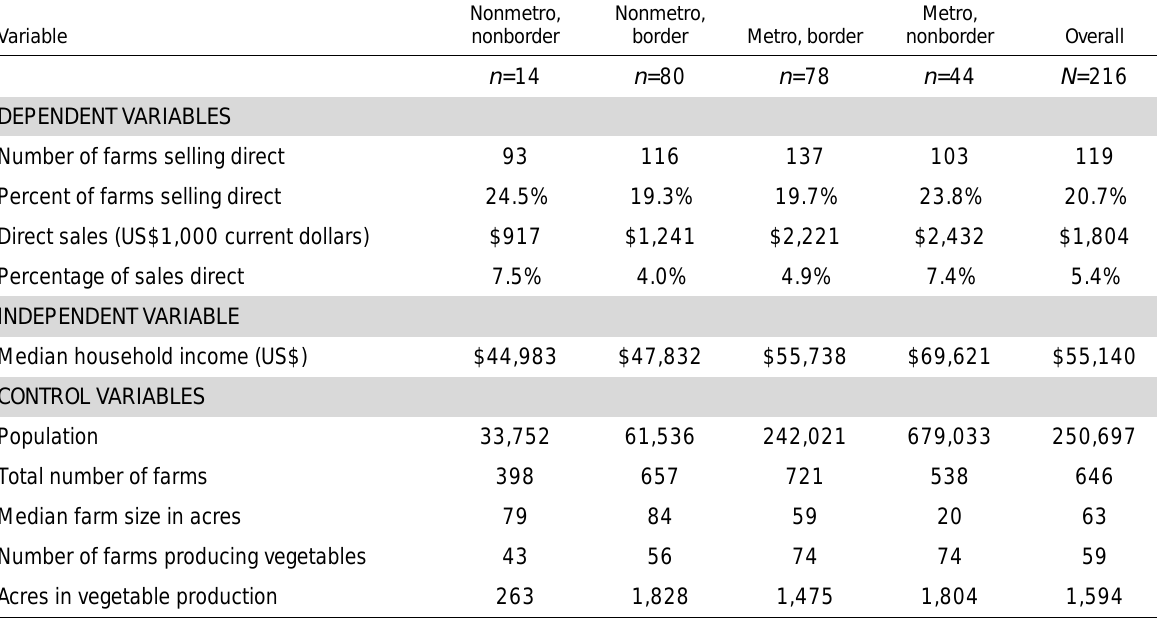
Table 2. Means by Metropolitan-Adjacency